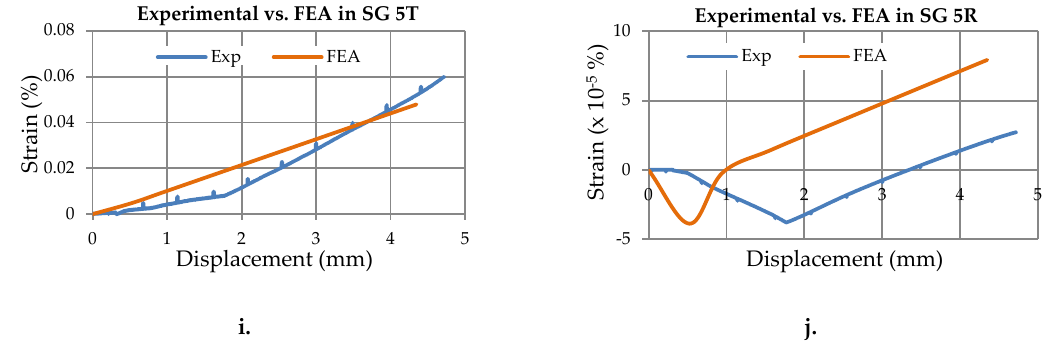
Figure 23. Comparison of the strain-displacement curves: Experimental versus FEA: ( a,b ) strain gauge (SG) no. 1 on tangential and radial directions; ( c,d ) strain gauge (SG) no. 2 on tangential and radial directions; ( e,f ) strain gauge (SG) no. 3 on tangential and radial directions; ( g,h ) strain gauge (SG) no. 4 on tangential and radial directions; ( i,j ) strain gauge (SG) no. 5 on tangential and radial directions. Table 5. Maximum strain values obtained on the composite plate in the five